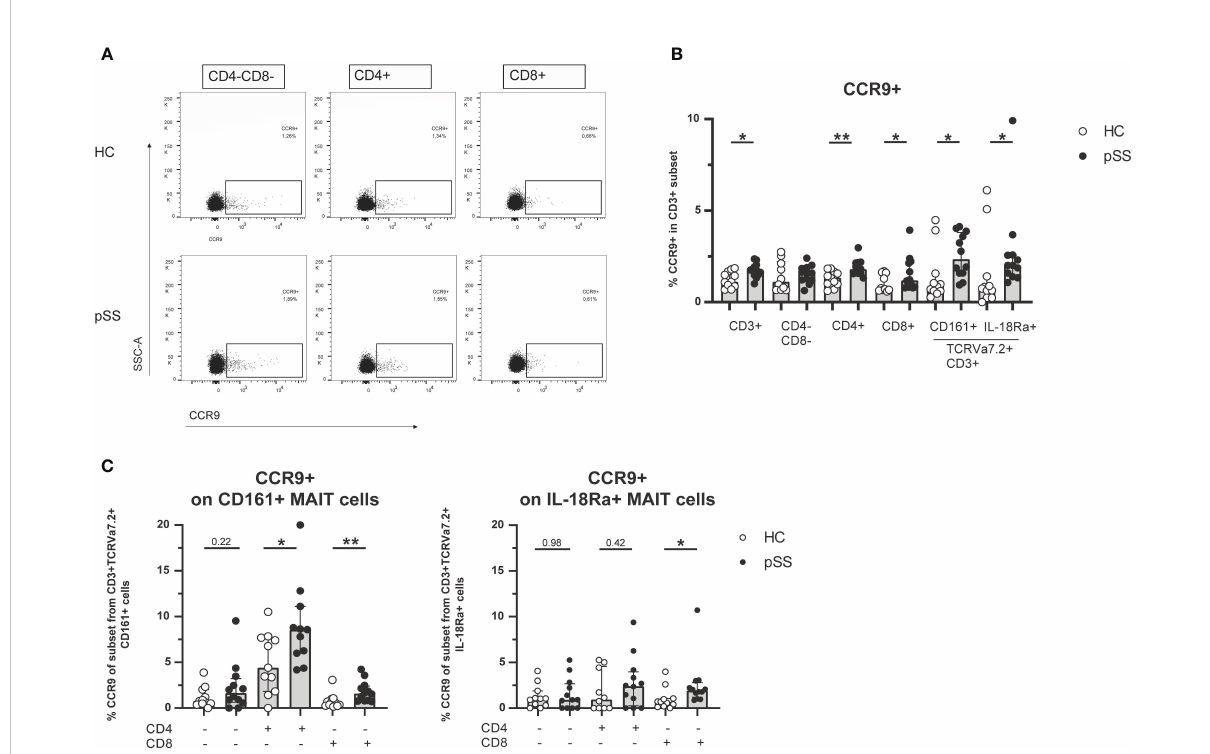
FIGURE 2 Increased frequencies of CCR9-expressing cells among circulating MAIT cells in pSS patients. (A) Representative fl ow cytometry plots of CCR9 expression on CD4-CD8-, CD4+, and CD8+ T cells from one pSS patient and one HC. (B) CCR9 expression is compared between pSS patients and healthy controls in different CD3+ cell subsets, including CD161 and IL18Ra-expressing MAIT cells. (C) In CD4-CD8-, CD4+, CD8+ cells from CD161+ and IL-18R a + MAIT cells CCR9 expression is quanti fi ed. Bar plots show median (interquartile range). HC, healthy control; pSS, primary Sjögren ’ s syndrome. *, ** indicates statistical signi fi cance of p < 0.05, p < 0.01,